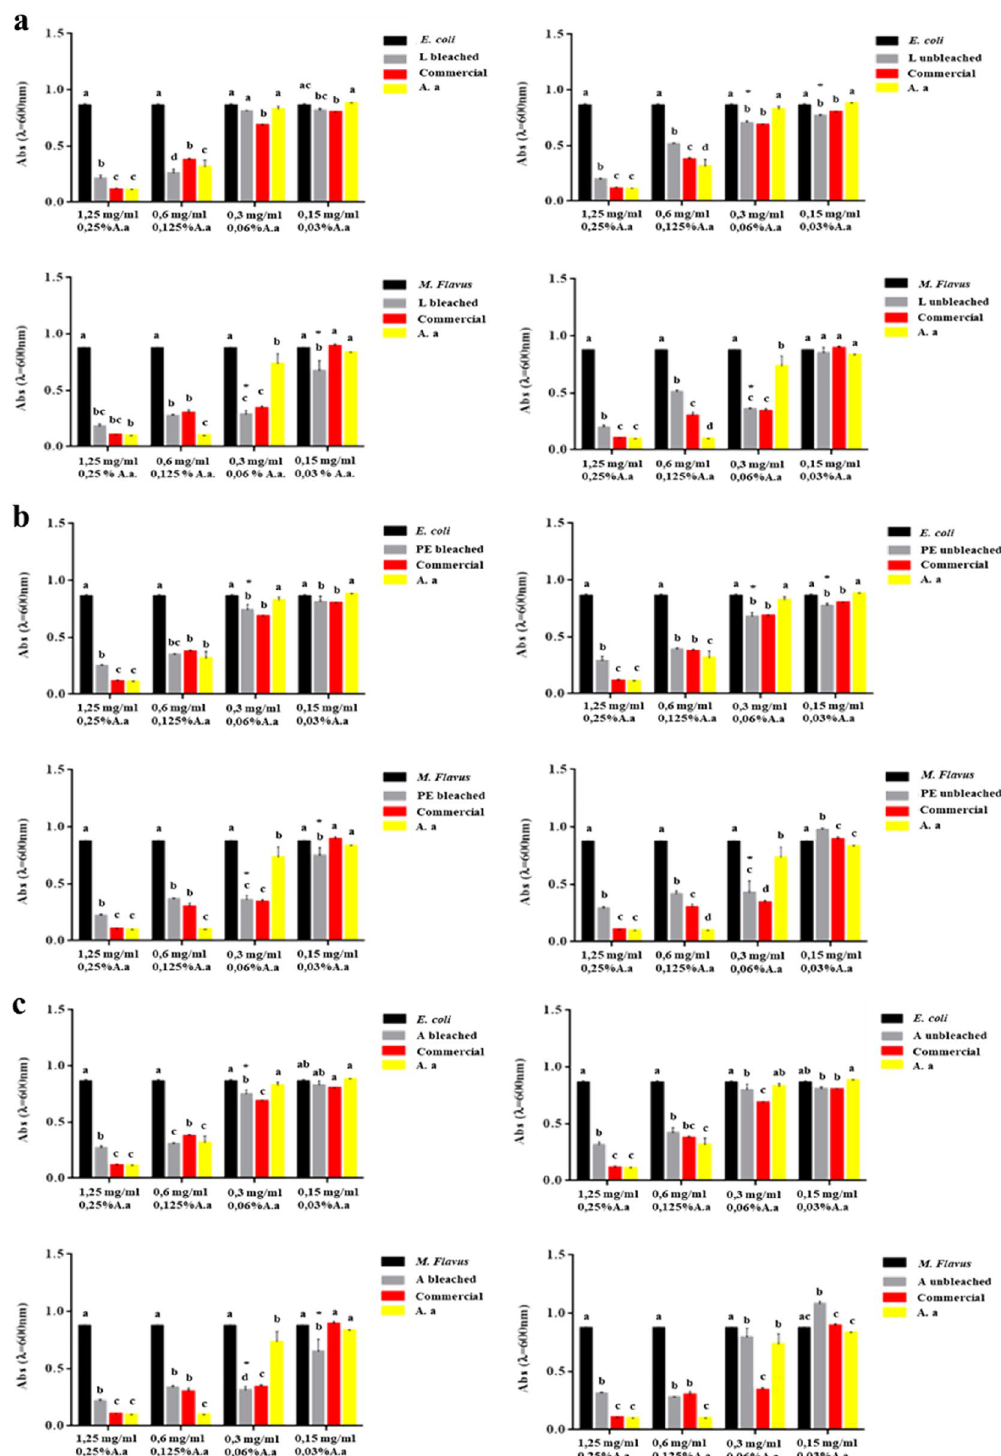
Figure 4. Results of microdilution assay for bleached and unbleached chitosan from larvae ( a ), pupal exuviae ( b ) and dead adults ( c ) of H. illucens , commercial chitosan and acetic acid at the four concentrations of 1.25, 0.6, 0.3, 0.15 mg/ml against E. coli and M. flavus . Bars indicate the absorbance of the bacterial culture (black bars) and that of the culture treated with H. illucens chitosan samples (gray bars), commercial chitosan (red bars) and acetic acid (yellow bars). Data are presented as mean ± standard error of three independent experimental biological replicates. Different letters indicate significant differences ( p < 0.05) between absorbance values of the bacterial culture alone and that of bacteria treated with the different concentrations of each treatment. Asterisks indicate significant differences ( p < 0.05) among treatments for the same concentration. Data are analyzed with two-way ANOVA and Bonferroni post-hoc